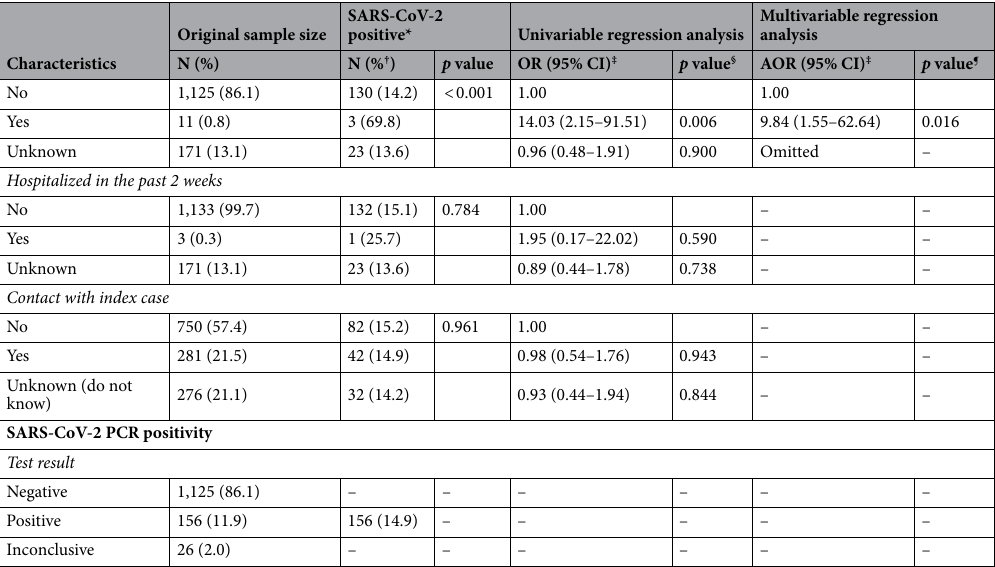
Table 2. Results of the community survey conducted on May 6–7, 2020 and associations with PCR positivity in Qatar. AOR adjusted odds ratio, CI confidence interval, OR odds ratio, PCR polymerase chain reaction. *Only 1,281 samples with confirmed results were analyzed. † Row percentages weighted by age and nationality. ‡ Estimates are weighted by age and nationality. § Covariates with p value ≤ 0.1 in the univariable analysis were included in the multivariable analysis. ¶ Covariates with p value ≤ 0.05 in the multivariable analysis were considered predictors of SARS-CoV-2 infection. # These include all other nationalities residing in Qatar. **Occupation categories were grouped together based on epidemiological relevance, that is to factor the frequency of social contacts (such as for the aviation sector and the police) or the effect of social and physical distancing restrictions (such as for hospitality, retail, and education sectors).